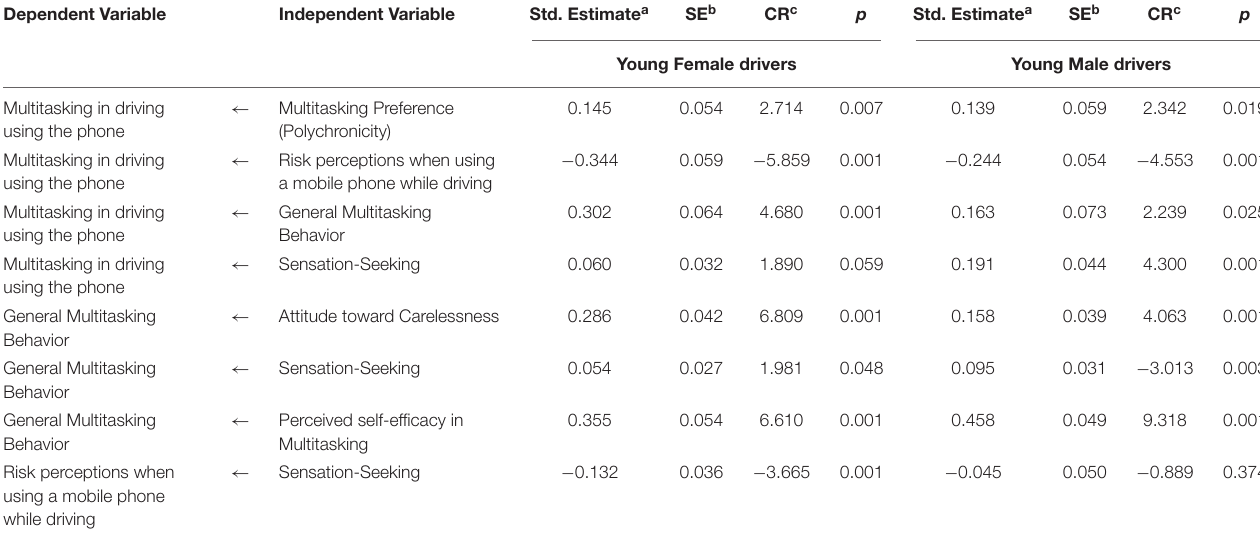
TABLE 4 | Gender-based Multi-Group (MGSEM) model for predicting the multitasking in driving using the phone. Dependent Variable Independent Variable Std. Estimate a SE b CR c p Std. Estimate